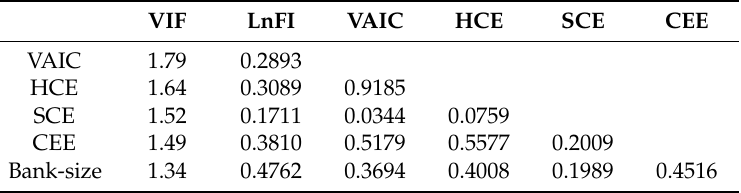
Table 2. Correlation